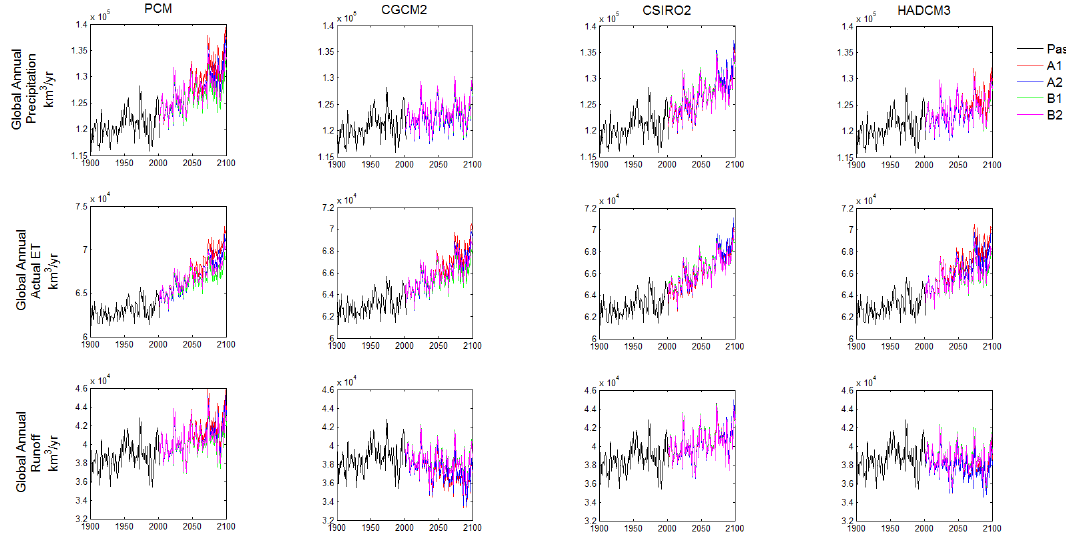
Figure 4. Global annual precipitation, actual evapotranspiration, and runoff from 1901–2100; future values are from four GCMs (PCM, Figure 4: Global annual precipitation, actual evapotranspiration, and runoff from 1901 – 2100; future values are from four GCMs (PCM, CGCM2, CGCM2, CSIRO2, and HADCM3) and for emission scenarios (A1fi, A2, B1, and B2). CSIRO2, and HADCM3) and for emission scenarios (A1fi, A2, B1, and B2)